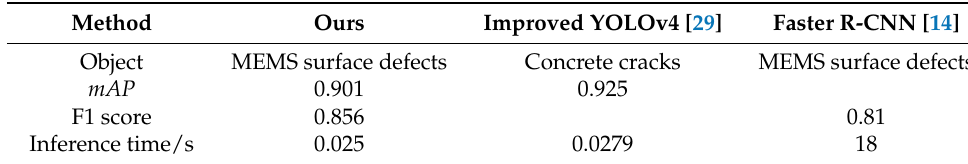
Table 6. Recent work